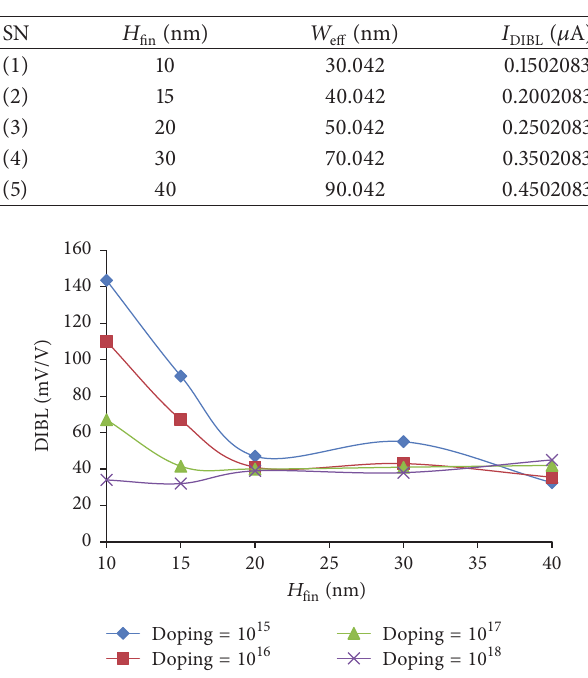
Figure 8: Variation of DIBL with fin height for different doping concentration at 1nm oxide